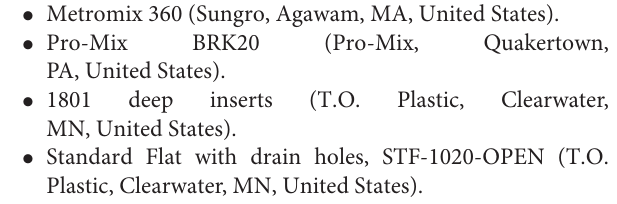
demonstrate that this improved B104 transformation protocol can be used for efficient genome editing